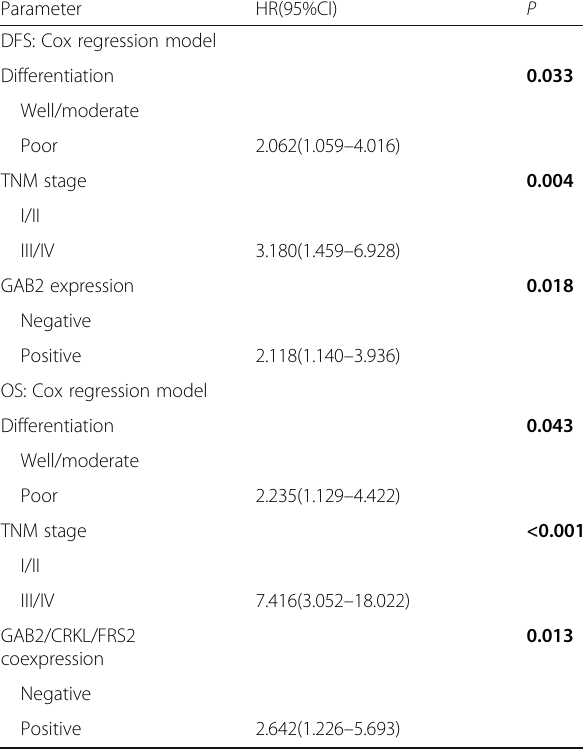
Table 4 Multivariate analyses for DFS and